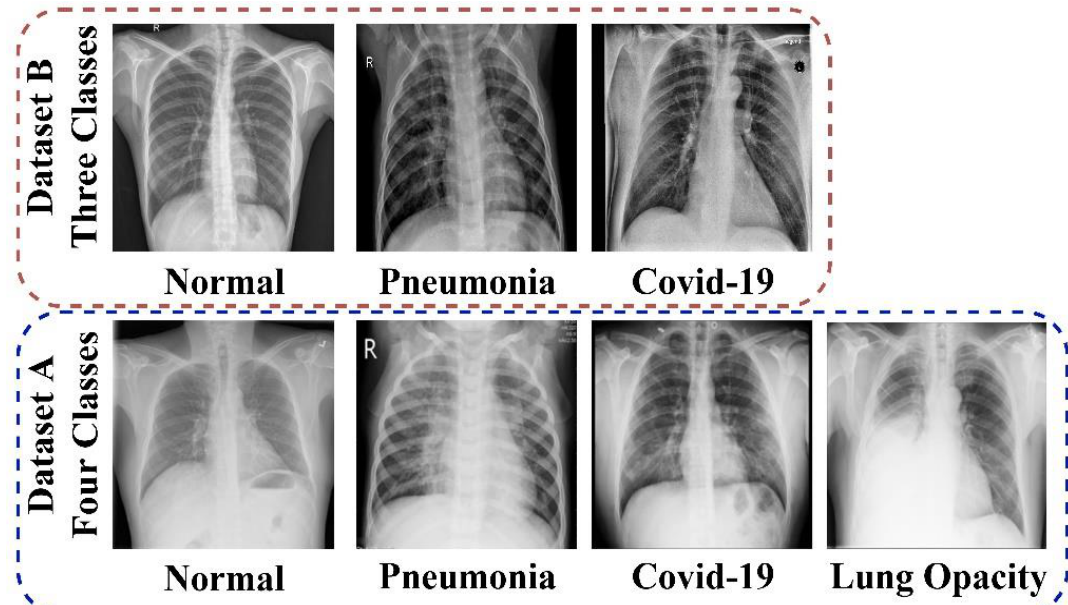
Figure 1. Sample of the employed dataset.